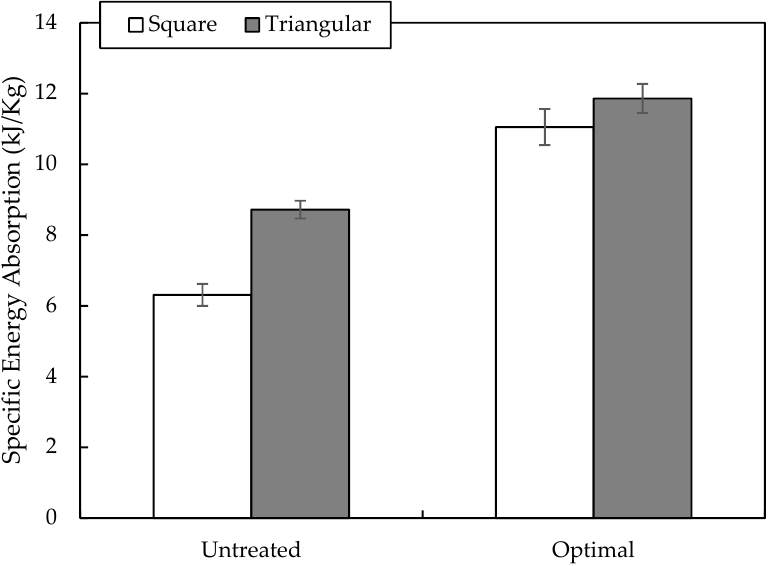
Figure 11. Energy absorption characteristics of bamboo reinforced epoxy square and triangular sandwich core structures.